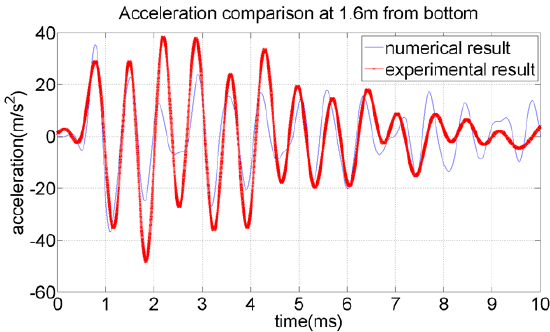
Figure 9. Comparison between experimental and numerical results using the bonded contact method.